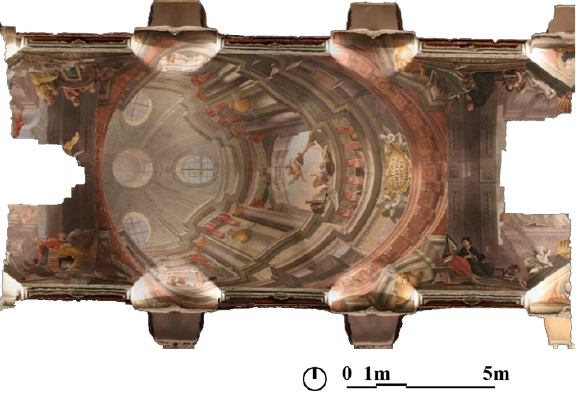
Figure 4. The illusionistic cupola at the vault intrados